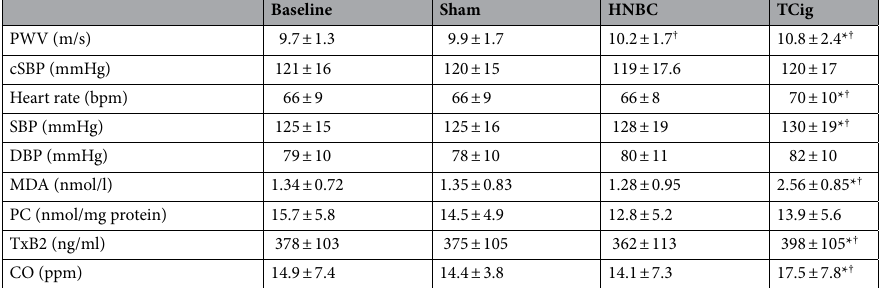
Table 2. Comparative acute effects of heat-not-burn cigarettes versus tobacco cigarette on arterial stiffness, oxidative stress, platelet activation, and exposure to CO in the acute study (n = 50). *p < 0.05 of the overall model by ANOVA for the within subject effects of the tobacco products. † p < 0.05 for the comparison of variables between baseline and after use of tobacco products by post hoc analysis using Bonferroni correction. PWV carotid-femoral pulse wave velocity, CO carbon monoxide, HNBC heat-not-burn cigarette, MDA malondialdehyde, TCig tobacco cigarette, TxB2 thromboxane B2, values are